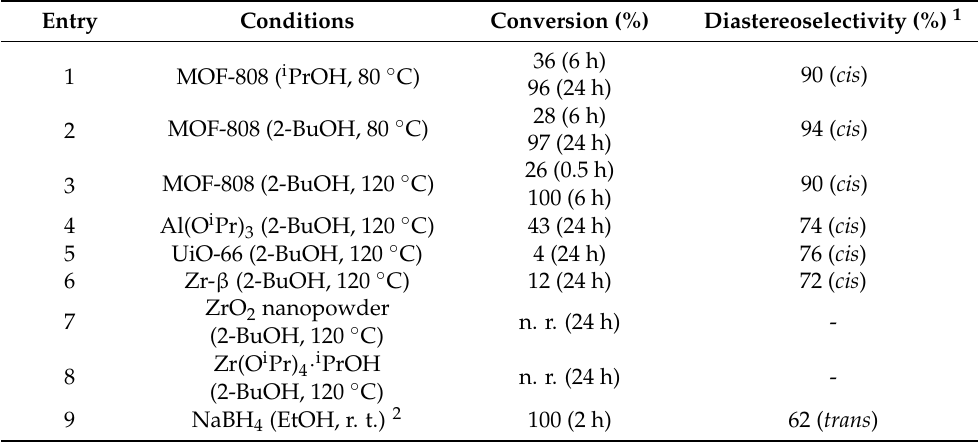
Table 3. MPV reaction of 2PhCH = O over various heterogeneous